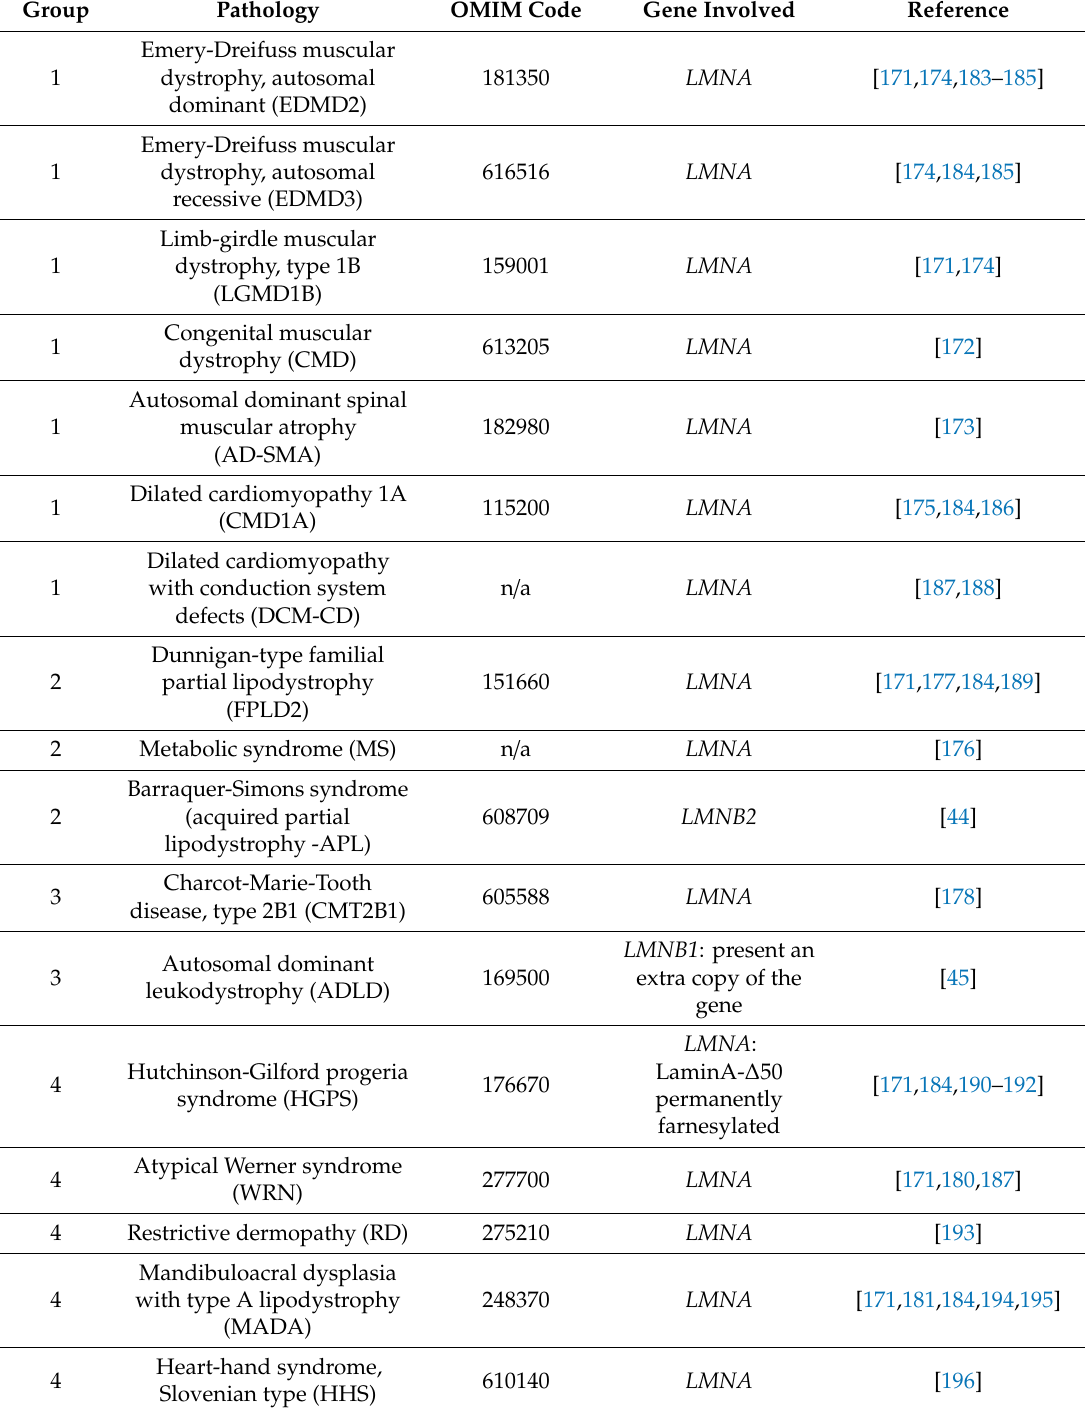
Table 4. Classification of